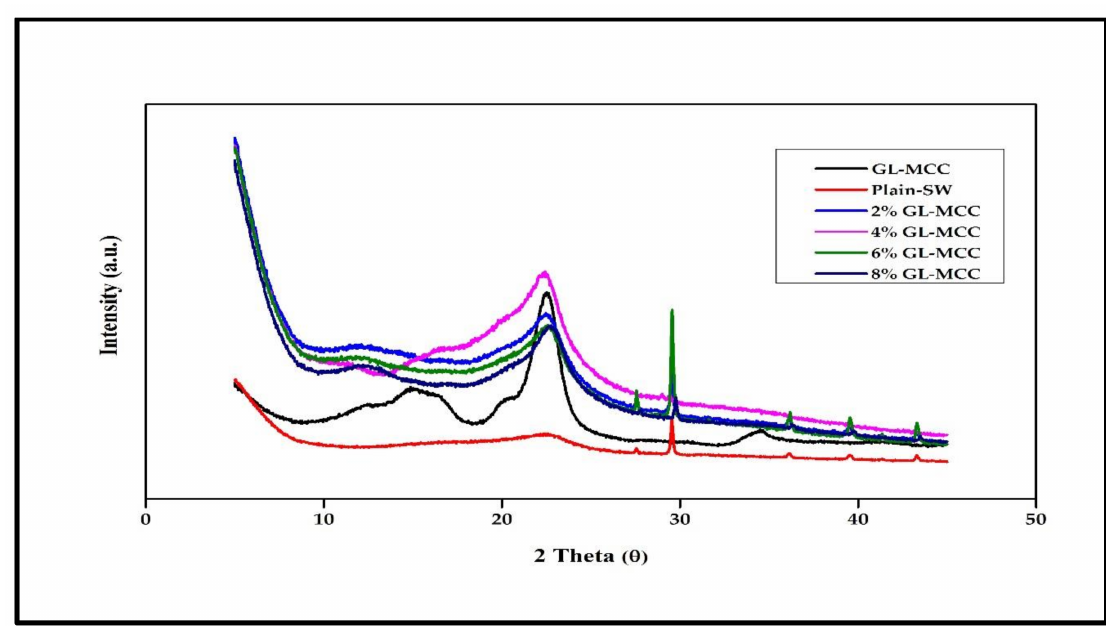
Figure 3. X-RD patterns of macroalgae (GL-MCC) and macroalgae (SW) / polysaccharide microfibre (GL-MCC) biopolymer